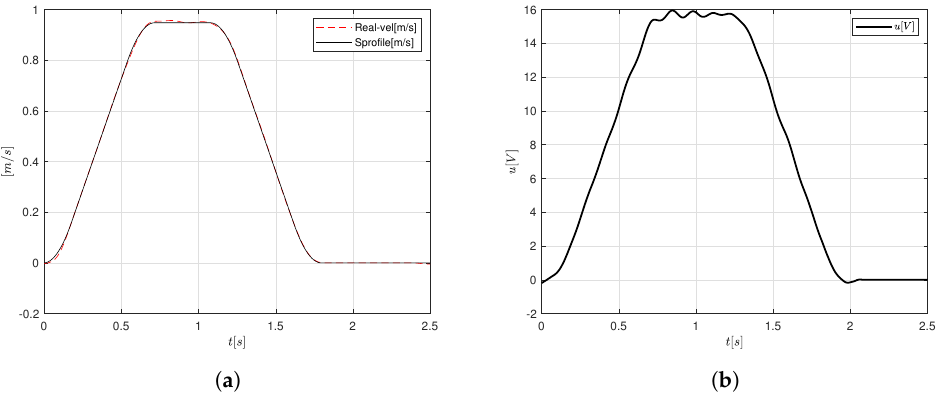
Figure 13. S-curve velocity profile implementation ( a ) velocity and ( b ) control signal.